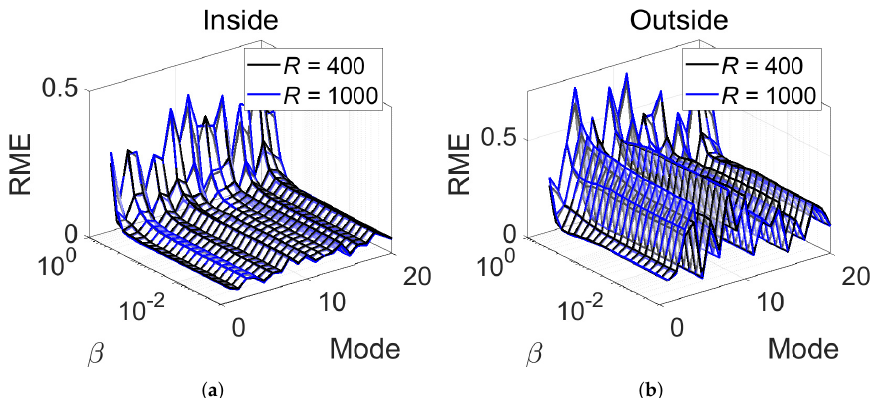
Figure 7. (Color online) RME of L1-parSBL versus the selection threshold β in different modes, ( a ) inside the virtual region (i.e., for interpolated field points) and ( b ) outside the virtual region (i.e., for extrapolated field